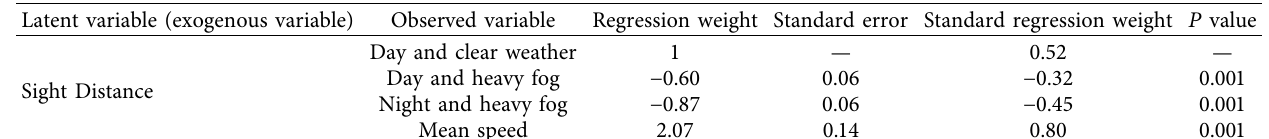
Table 12: SEM results for the latent variable “Sight Distance.”